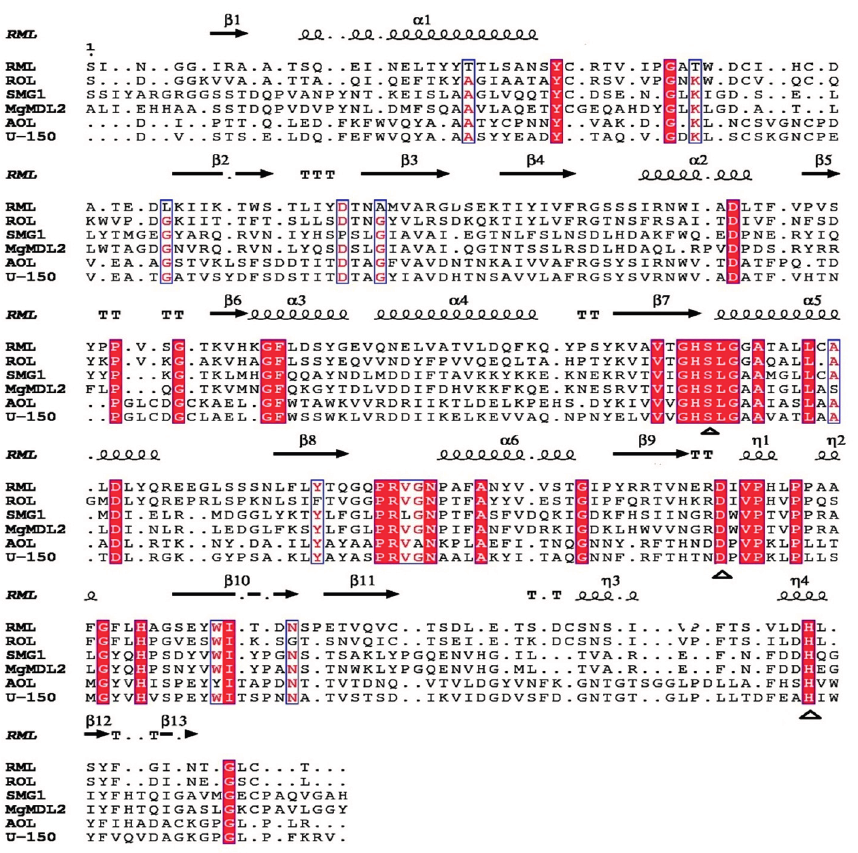
Figure 1. Multiple sequence alignment of Mg MDL2. The lipases sequence included U-150 from P. camembertii U-150 (PDB: 1TIA_A), AOL from A. oryzae (XP_001823459 in GenBank), PCL from P. cyclopium (ADE87963 in GenBank), SMG1 from M. globosa (PDB: 3UUE), Mg MDL2 from M. globosa (XP_001732206 in GenBank), RML from R. miehei (PDB ID: 4TGL) and ROL from R. oryzae (PDB ID: 1TIC). Identical residues were marked with red background and the highly conserved residues were showed as red font. The catalytic triads are indicated with